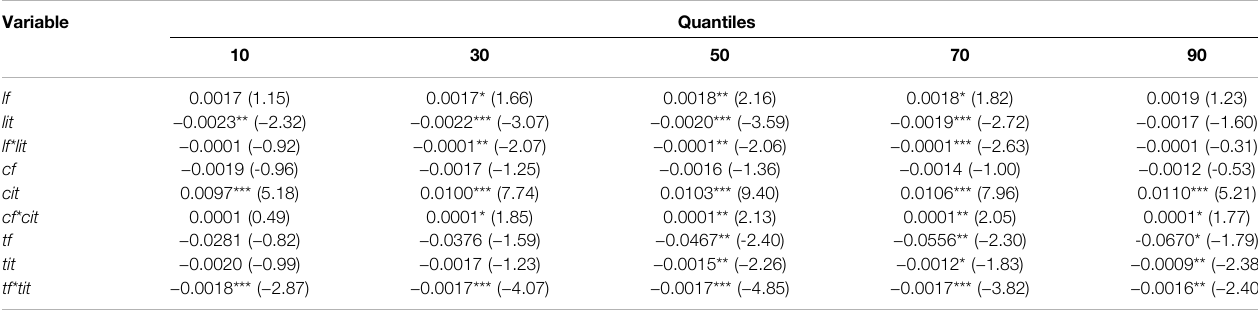
TABLE 5 | Results of quantile